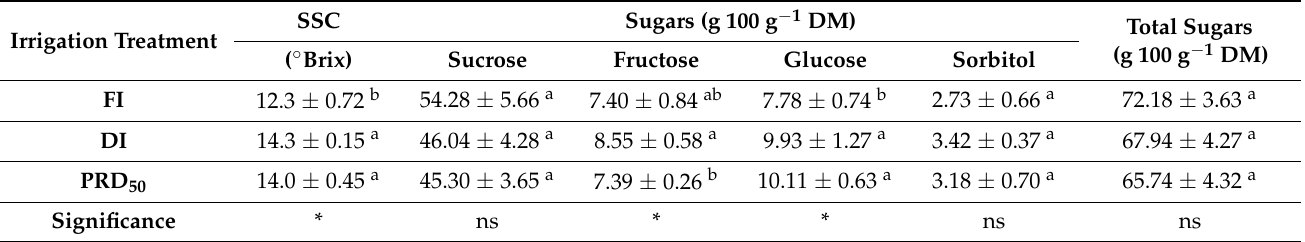
Table 2. Soluble-solid content (SSC) and sugar contents in Flordastar peach fruit samples harvested in 2016 subjected to different irrigation treatments (FI, DI and PRD 50 ).